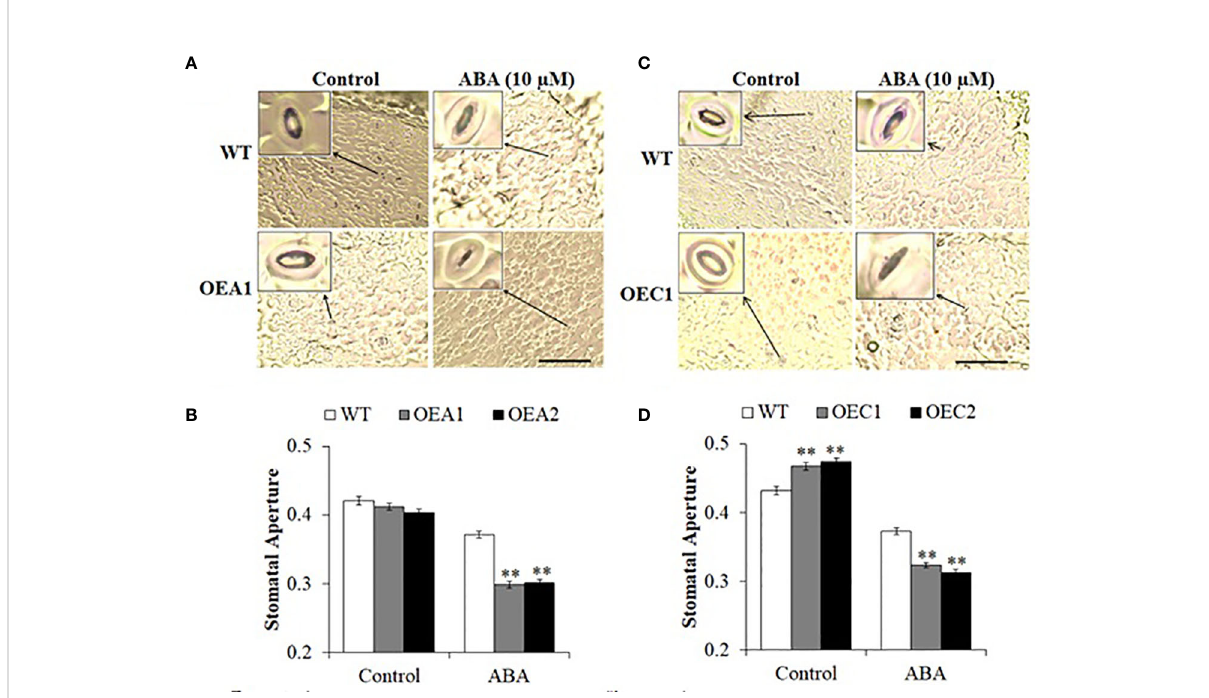
FIGURE 4 Stomatal closure under stress in HD2A and HD2C overexpression lines. Images of stomatal pore opening and closure observed in WT, HD2A- OE line (A) and HD2C-OE line (C) under control and ABA-induced stress (scale bar: 50 µm). (B) Stomatal aperture measured as width/length of stomatal pores in WT, HD2A-OE lines, OEA1 and OEA2 (B) and HD2C-OE lines, OEC1 and OEC2 (D) under control and ABA-induced stress. Data shown are means ± standard errors from at least 150 stomata. Three independent experiments were performed in this test. In each experiment, stomatal measurements were taken from three plants of each genotype (two leaves per plant). The signi fi cance of the differences between different genotypes was determined by Student ’ s t test (**p <